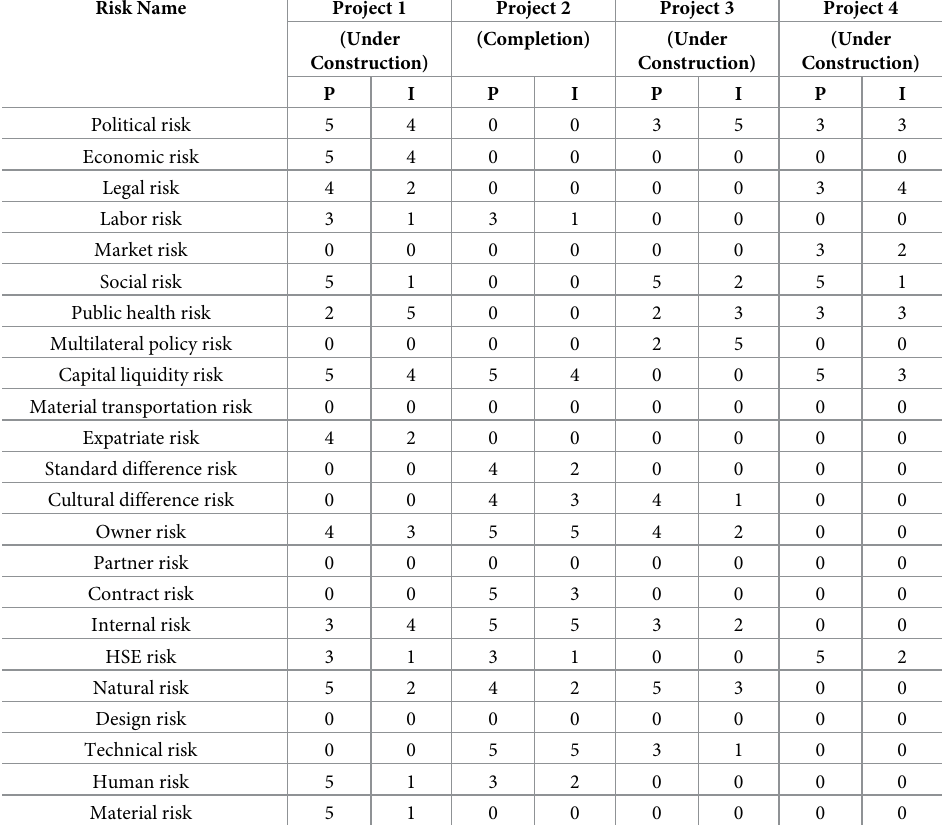
Table 4. Probability and impact of the risks that occurred in similar